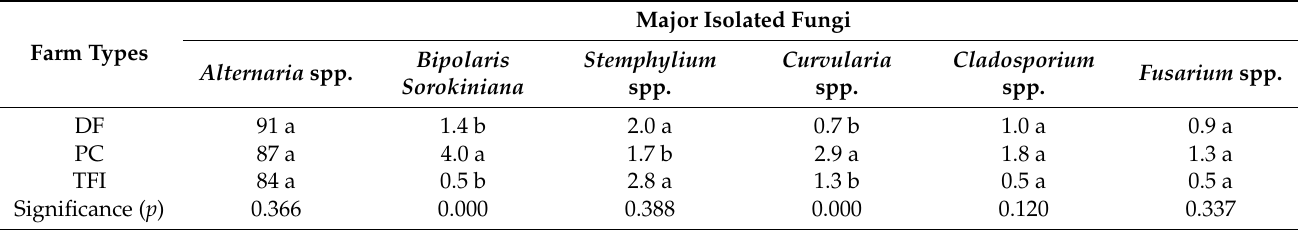
Table 4. Frequency of wheat grain infection with major seed-borne fungi categorized according to farm type (DF = dehkan farm; PC = production cooperative; TFI = Tajik Farming Institute farm). Major Isolated Fungi Farm Types Alternaria spp.